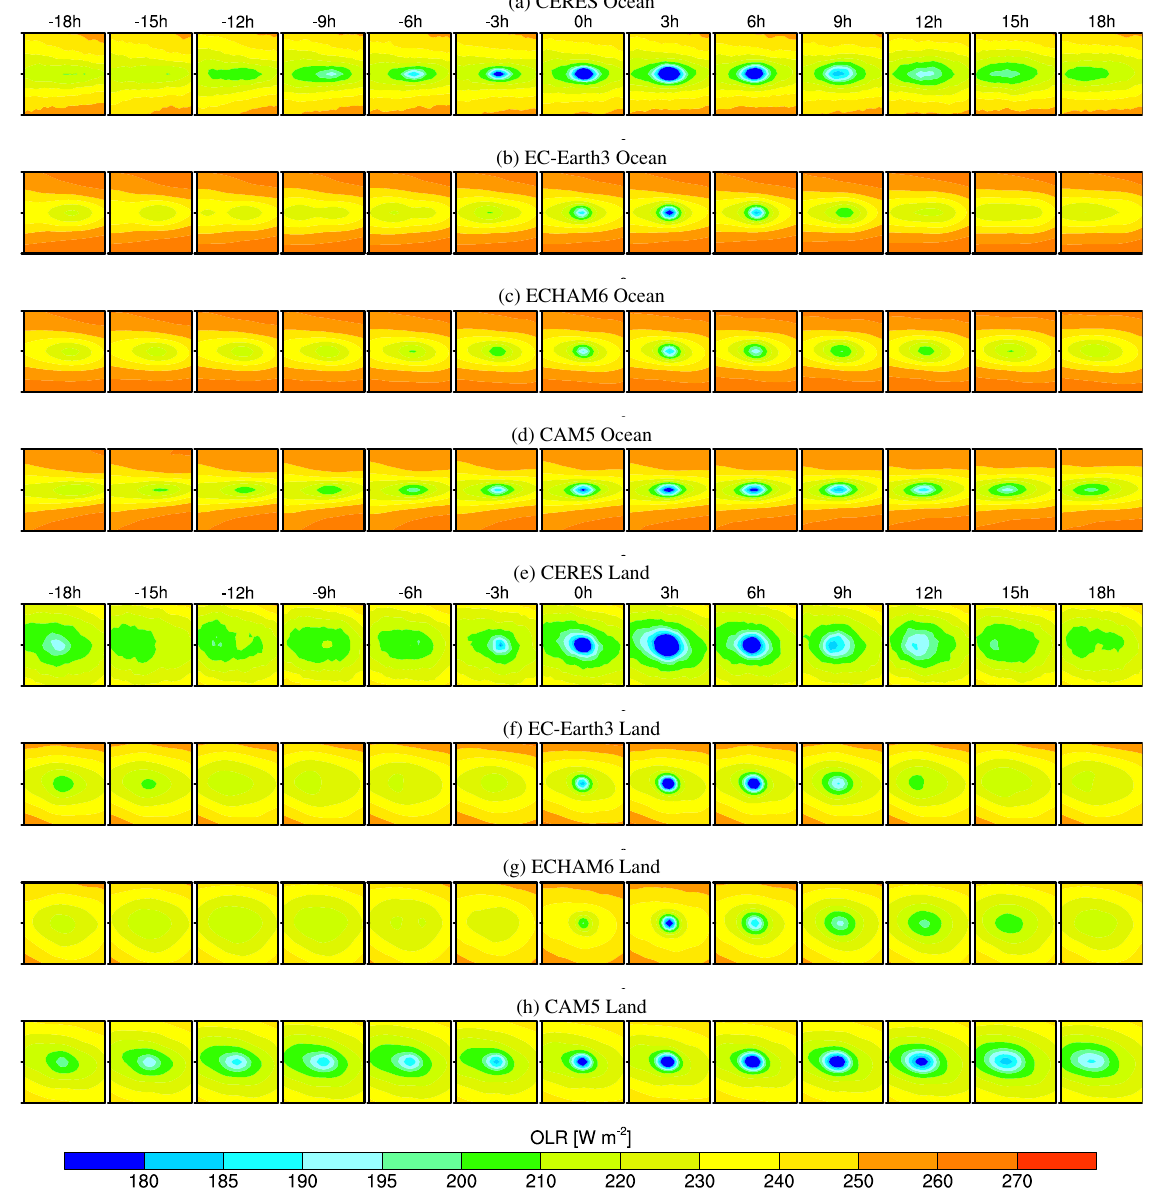
Figure 10. Composite of outgoing longwave radiation (OLR) for ocean-based (a–d) and land-based (e–h) systems for the Cloud and Earth Fig. 10. Composite of outgoing longwave radiation (OLR) for ocean-based ((a)-(d)) and land-based ((e)-(h)) systems for the Cloud and Earth Radiant Energy System (CERES) followed by the models. The spatio-temporal coverage of ± 18 hours at every 3-hour interval and ± 10 ◦ Radiant Energy System (CERES) followed by the models. The spatio-temporal coverage of ± 18h at every 3h interval and ± 10 ◦ longitude longitude and latitude taken from the centre point and graduated every ± 1 ◦ . and latitude is taken from the centre point and graduated every ± 1 ◦ The models also exhibit zonally propagating convection. 16 different models and found similar differences between As in TMPA, both westward and eastward propagating equa- a range of models. Over the ocean, EC-Earth3 exhibits rel- torial waves are present in the models. These results are in atively fast eastward-moving DC systems embedded within agreement with Blackburn et al. (2013) who examined the slower westward propagating convective envelopes. The re- motion of equatorial precipitation for a 30-day period for maining models show no clear zonal motion. Over land, the